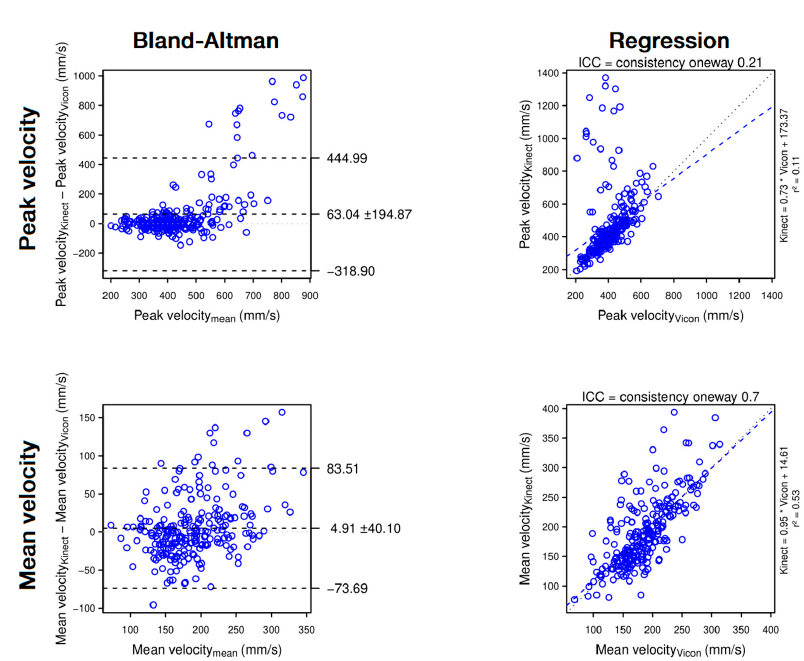
Figure 6. Bland–Altman plots ( left panels ) and regression plots ( right panels ) of peak hand velocity (1st row) and mean hand velocity (2nd row). The Bland–Altman plots show that the Kinect slightly overestimates peak hand velocity and mean hand velocity. The regression plots show that, when assessed with the Kinect, mean velocity is moderately reliable but peak velocity is only poorly reliable.